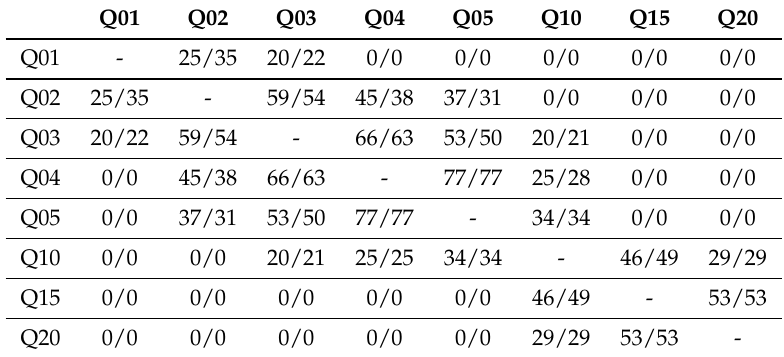
Table 9. Test results for similar plain text files with LZJD (signature comparison/file comparison).